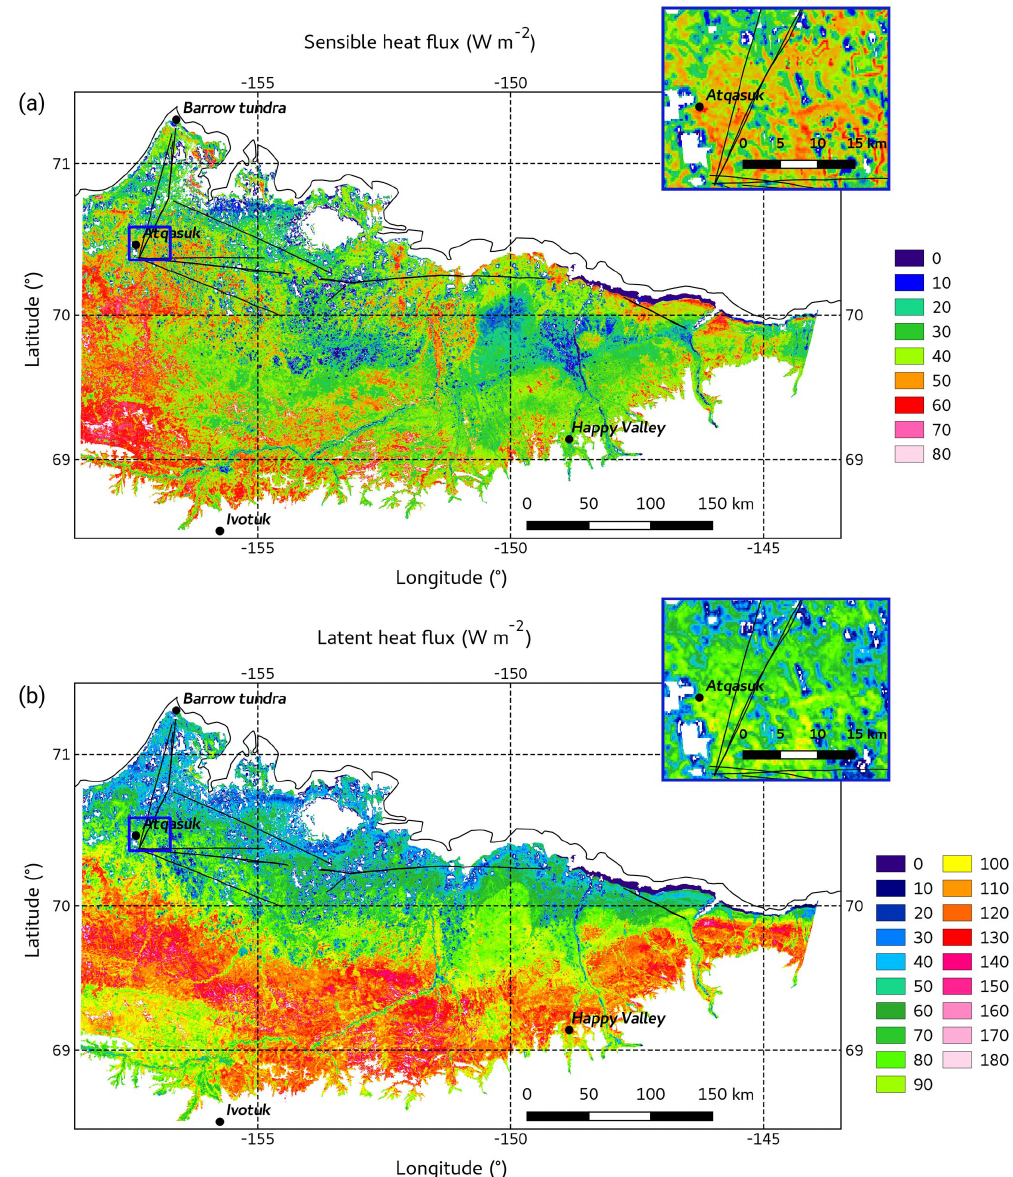
Figure 8. Median sensible heat (a) and latent heat (b) fluxes over the North Slope of Alaska, averaged over the reference period. Only those fluxes with a standard error of the median value < 30% are shown. The insert shows the location of the EC tower in Atqasuk that provided the measurements used for the comparison in Sect. 3.4. Black lines represent Polar 5 flight